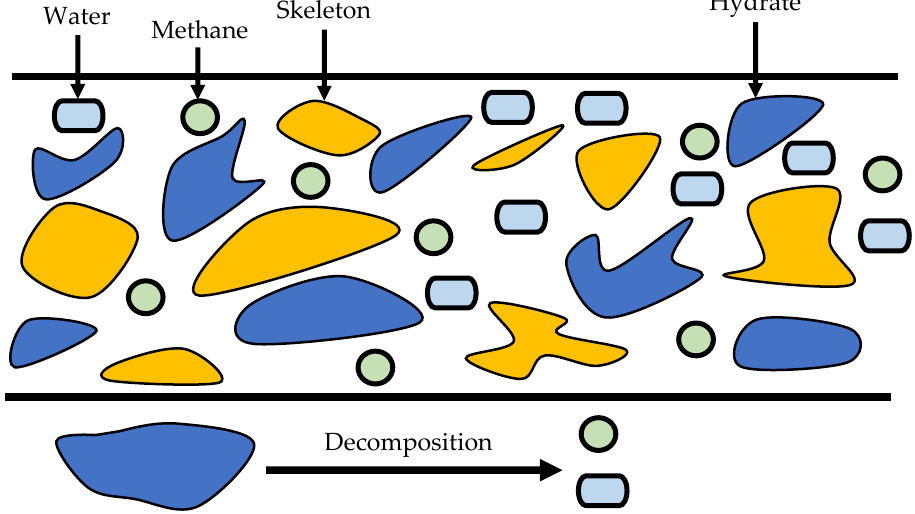
Figure 1. Scheme of the problem of the MHs decomposition in a one-dimensional model in the case of multiphasic flow [49].